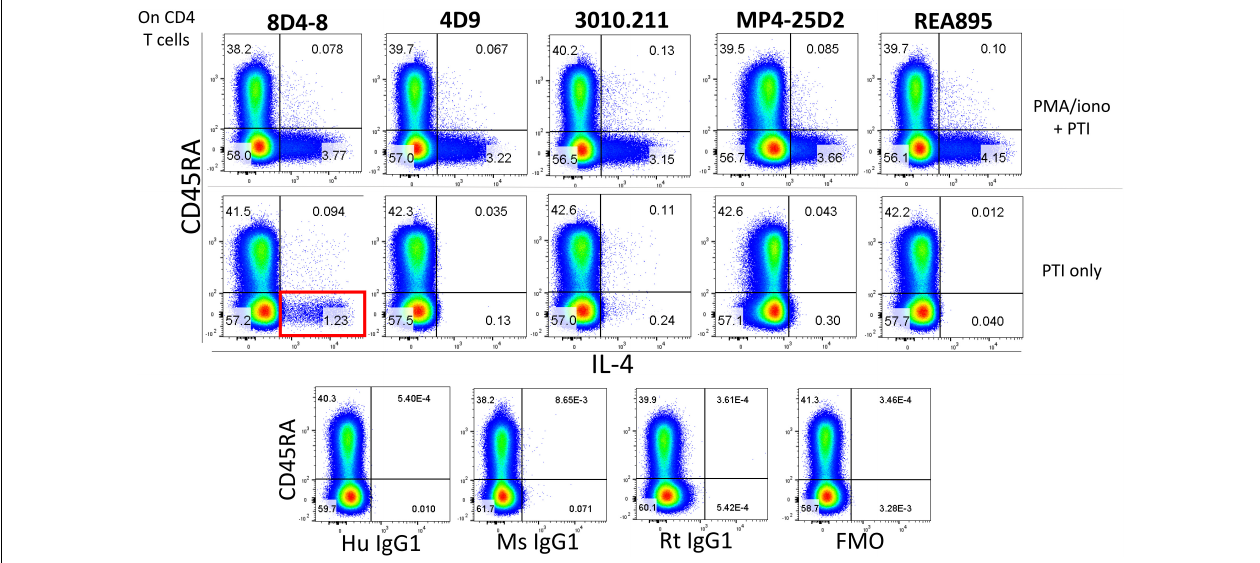
FIGURE 1 | Anti-IL-4 clone 8D4-8 uniquely detects a population of events in the absence of PMA/ionomycin stimulation. CD4 T cells were identified as CD4 + , CD8 − , CD3 + , Live/Dead − , singlet events (not shown). Anti-IL-4 clones 8D4-8, 4D9, 3010.211, MP4-25D2, and REA895 identify comparably sized subsets among CD45RA − CD4 T cells following PMA/ionomycin stimulation. However, clone 8D4-8 identifies a sizeable population of events (red box) following culture with only brefeldin A and monensin (protein transport inhibitors, PTI). Isotype and fluorescence minus one (FMO) controls are shown at bottom for reference. Mouse IgG1 is the isotype for 8D4-8, 4D9, and 3010.211, rat IgG1 is the isotype for MP4-25D2, and human IgG1 is the isotype for REA895. Data shown are representative from 3 experiments from 3 donors.